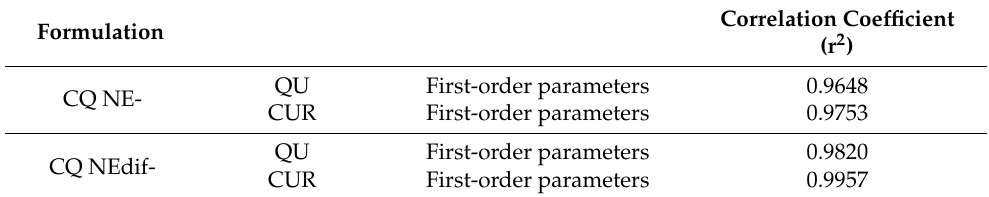
Table 7. Kinetics parameters obtained from CUR and QU release profiles.